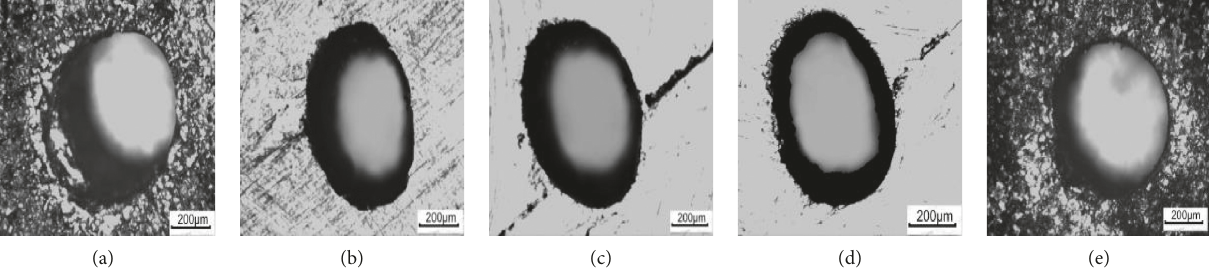
Figure 12: Milled sections of a machined cooling hole samples. (a) Section 1. (b) Section 2. (c) Section 3. (d) Section 4. (e) Section